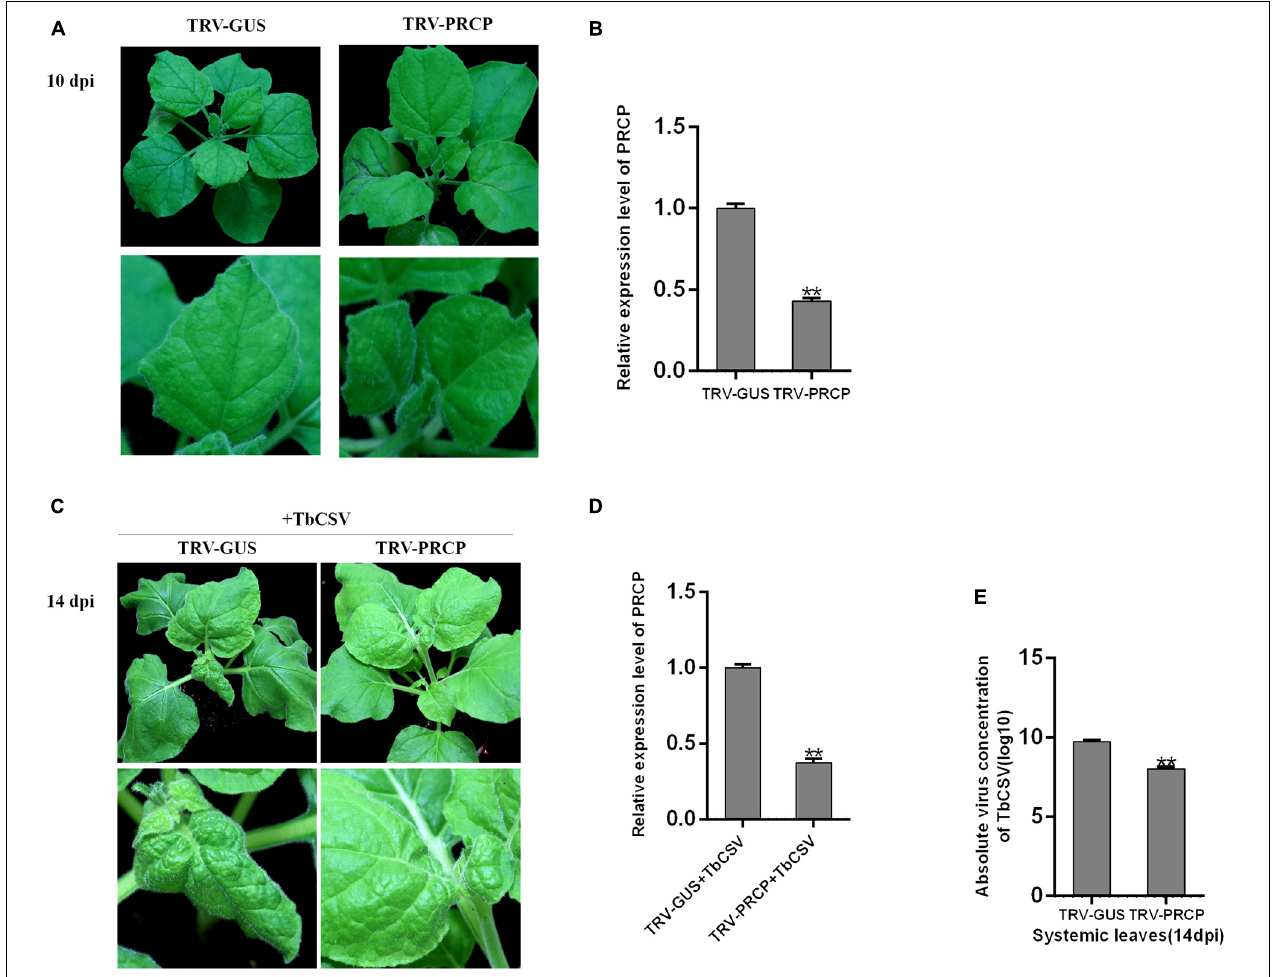
FIGURE 6 | Effect of PRCP on TbCSV pathogenicity. (A) Tobacco rattle virus (TRV)-based vector (TRV-PRCP) was used to down-regulate the expression of PRCP . (B) The expression level of PRCP in TRV-PRCP-treated plants was significantly reduced compared with that in control plants. (C) TbCSV was inoculated onto TRV-PRCP-treated and control plants 10 days after VIGS treatment. (D) The level of PRCP in TbCSV-infected and TRV-PRCP-treated plants was significantly down-regulated compared with that in TbCSV-infected and TRV-GUS-treated plants. (E) Detections of TbCSV DNA copy numbers in the systemic leaves harvested from the TRV-GUS plus TbCSV-inoculated plants or the TRV-PRCP plus TbCSV-inoculated plants. Significance of difference between treatments (* p < 0.05; ** p < 0.01) was determined by the Student’s t